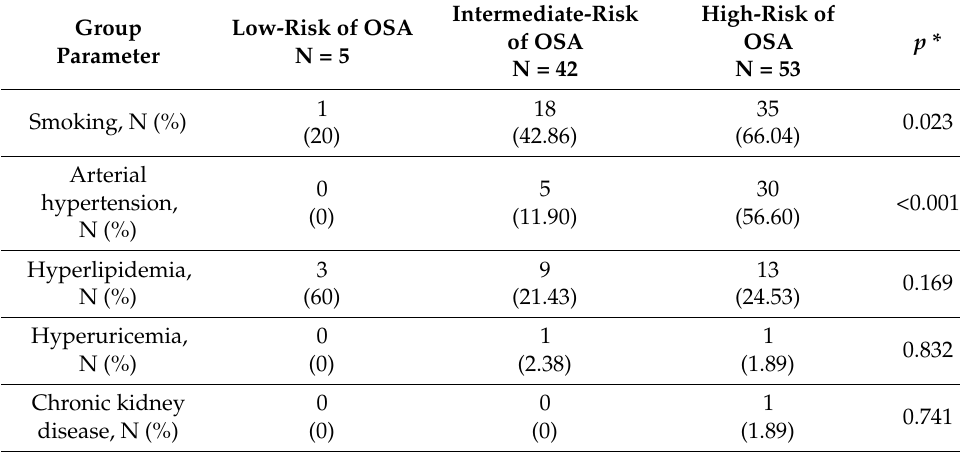
Table 4. Prevalence of other cardiovascular risk factors according to OSA risk, number of partici- pants